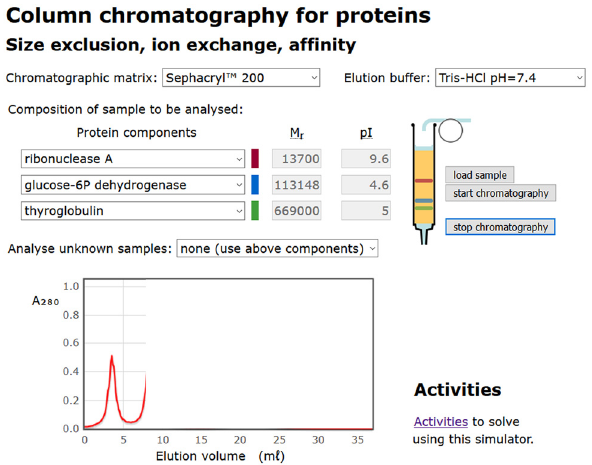
Figure 3: A simulation of column chromatography for protein samples. As the separation proceeds, coloured bands progress along the column and the chromatogram is plotted